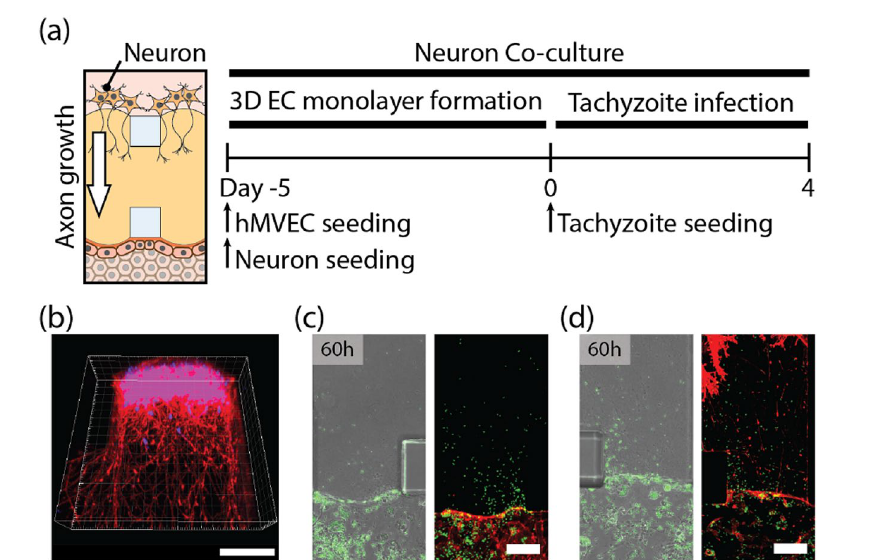
Figure 4. Tachyzoite infection of the EC monolayer co-cultured with neurons. ( a ) Time line for EC monolayer formation (with neurons) and tachyzoite infection. ( b ) Confocal image of neurons (rhodamine-phalloidin (red) and DAPI (blue)) on ECM shows the 3D migration of axons into ECM. Fluorescent images after 60 h of tachyzoite infection ( c ) without and ( d ) with neurons. Scale bars indicates 100